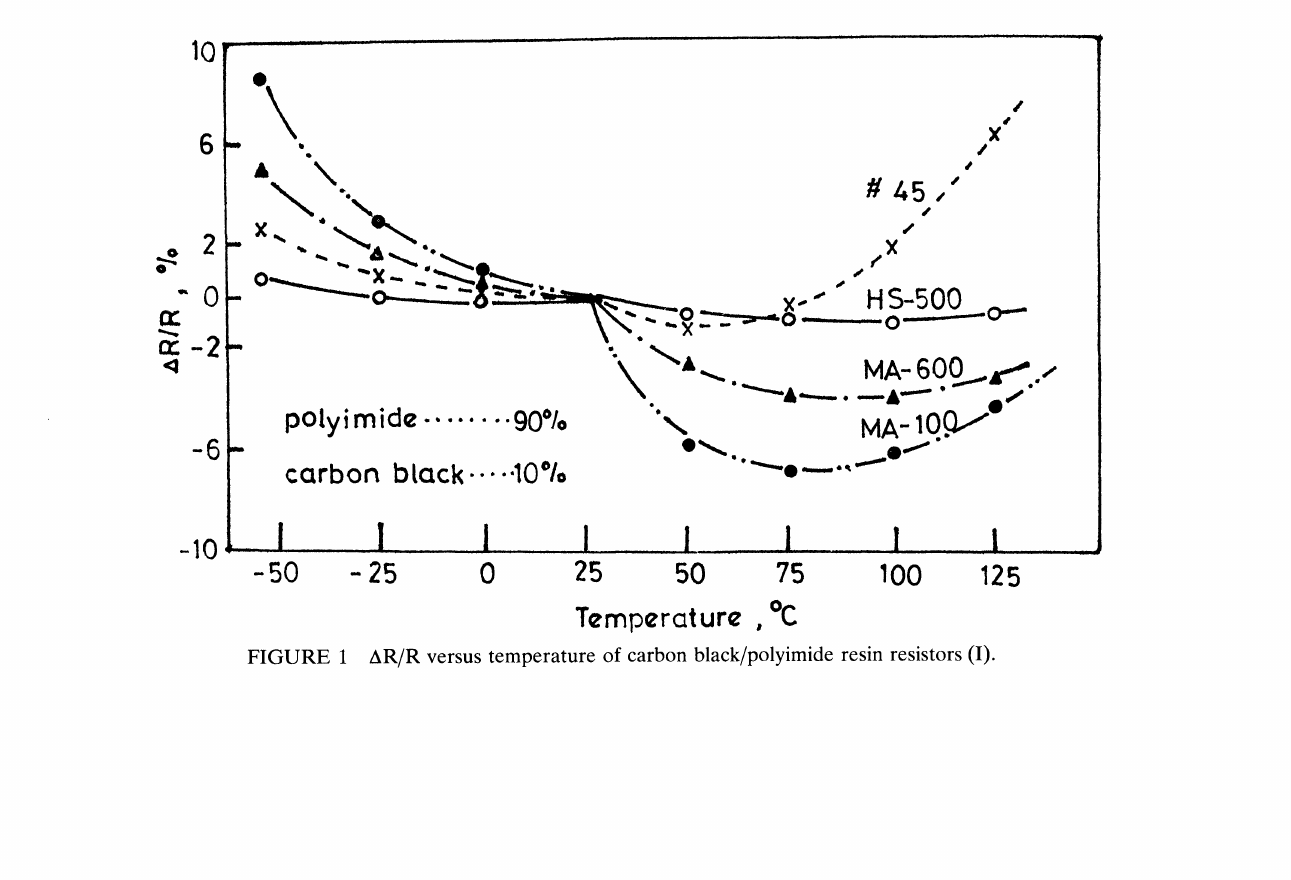
FIGURE AR/R versus temperature of carbon black/polyimide resin resistors